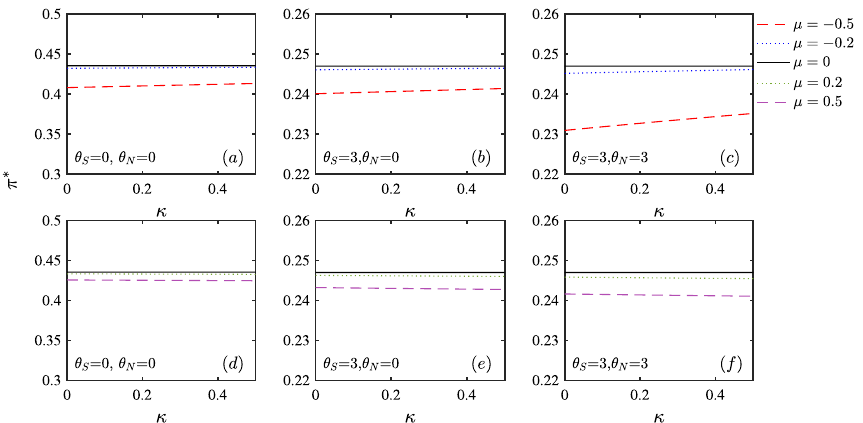
Fig. 9 Effects of price and volatility jump sizes on portfolio choice in Bitcoin market. The top three panels show downward price jumps and no jump, while the bottom three panels show upward price jumps and no